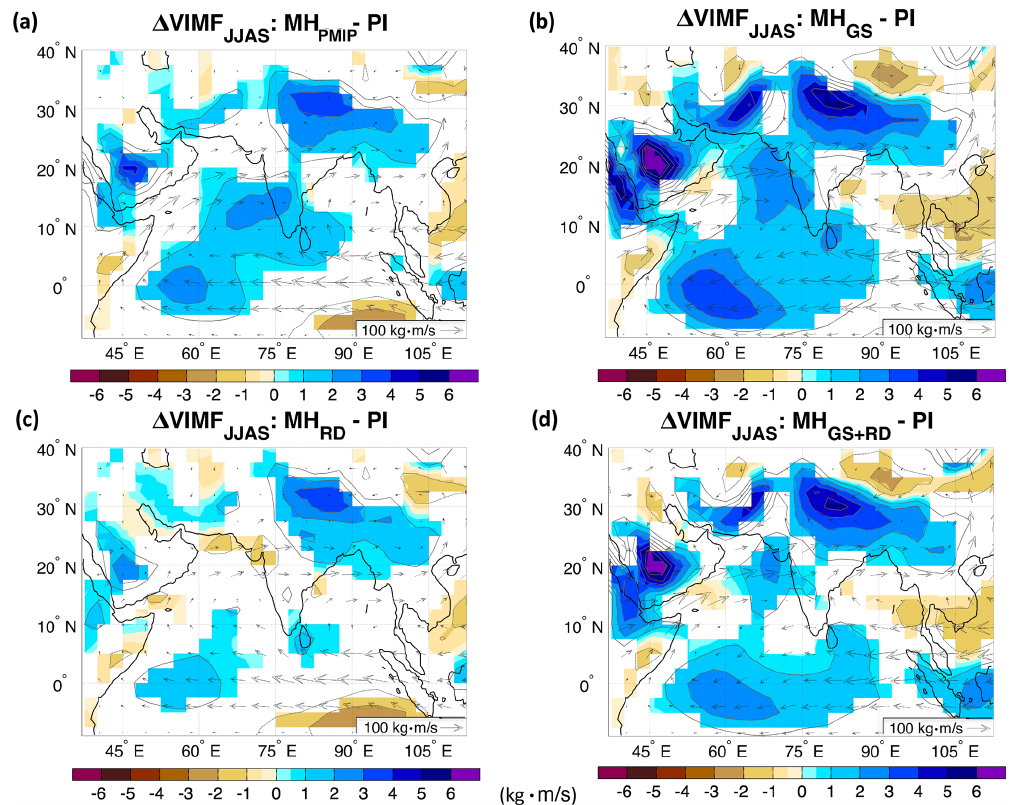
Figure 8. Changes in summer (JJAS) vertically integrated (from 1000 to 300hPa) horizontal moisture flux (VIMF; kgm/s) for the (a) mid- Holocene-only orbital forcing (MH PMIP ); (b) the Sahara greening (MH GS ); (c) the dust-only reduction (MH RD ); and (d) the Sahara greening and dust reduction (MH GS + RD ) experiments relative to the PI reference simulation. The contour lines follow the color-bar scale (the 0 lines are omitted for clarity). The arrows represent the zonal and meridional components of the moisture flux. Only differences significant at the 95% confidence level using the Student t test are